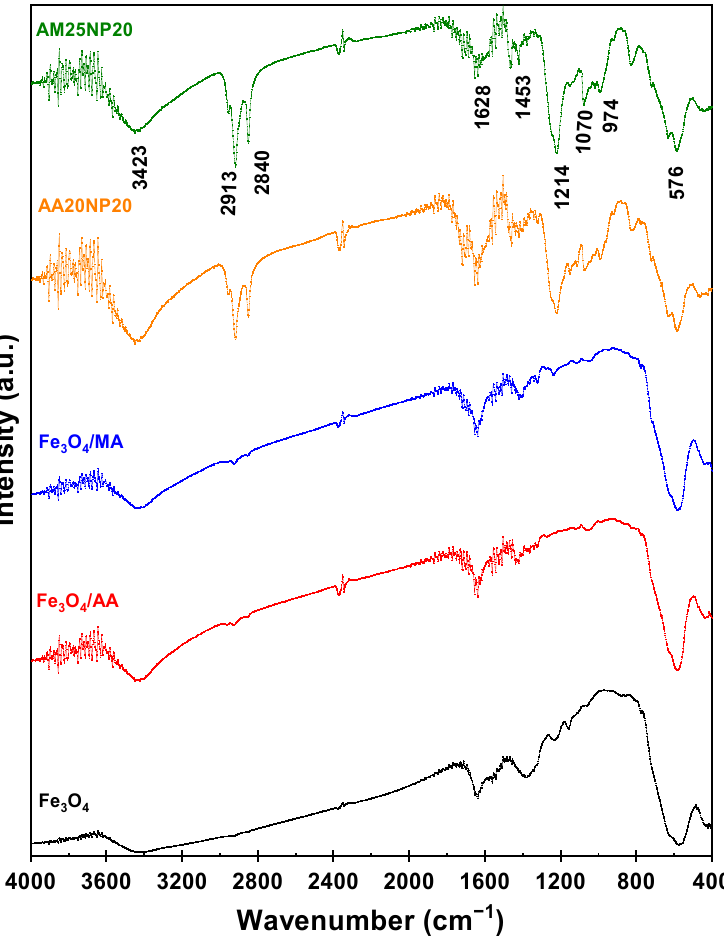
Figure 3. FTIR measurements of pure Fe 3 O 4 nanoparticles, acrylic acid-modified Fe 3 O 4 , methacrylic acid-functionalized Fe 3 O 4 nanoparticles, and magnetic polymer nanocomposites (AM25NP20 and AA20NP20).